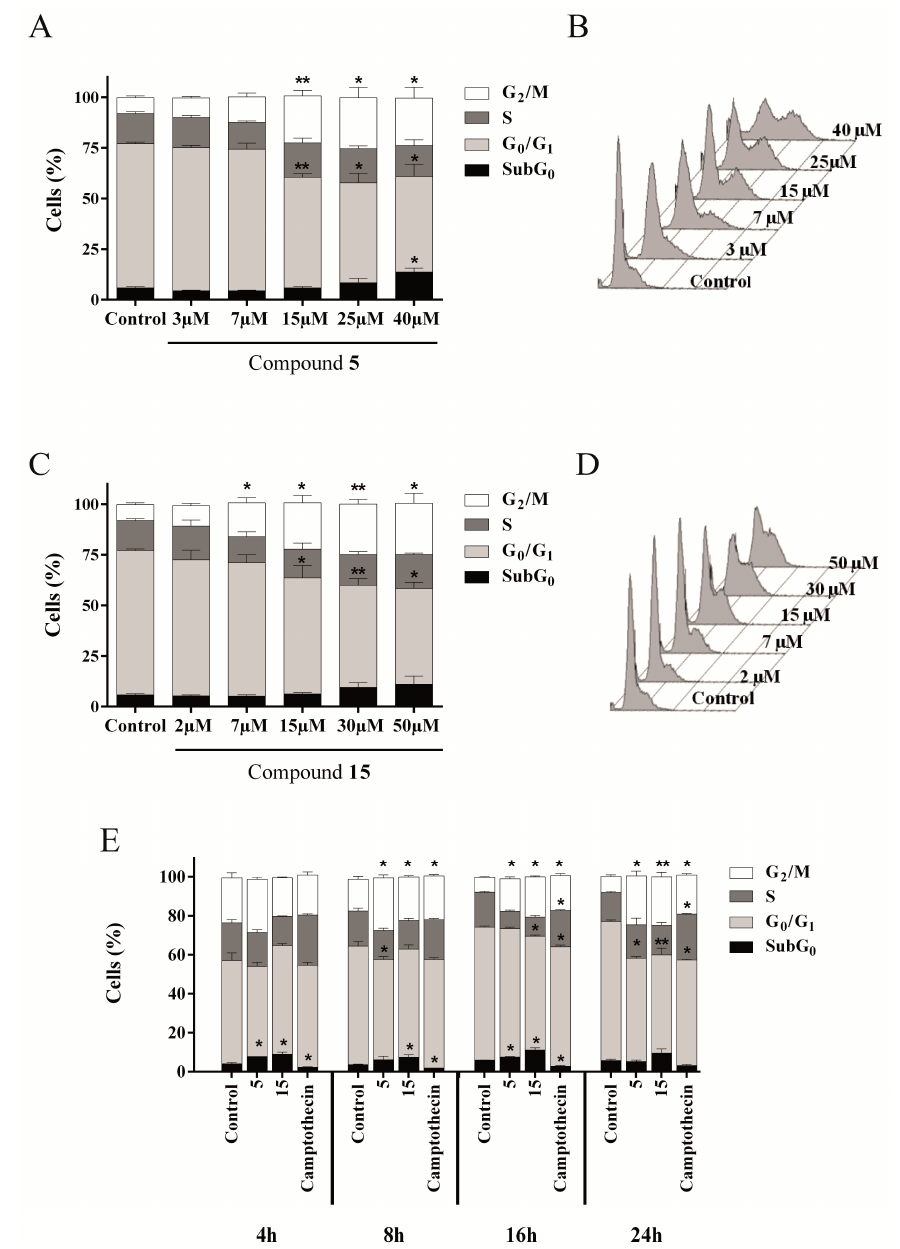
Figure 4. Compounds 5 and 15 induce cell cycle arrest in G 2 /M phase in MCF7. MCF7 cells were treated with different concentrations of compound 5 , 15 or vehicle (control) for 24 h or for different time periods. Cells were stained with propidium iodide with the Apo-Direct kit and analyzed by flow cytometry. ( A ) Quantification of cell cycle distribution after 24 h treatment with increasing concentrations of compound 5 ; ( B ) Representative experiment of A; ( C ) Quantification of cell cycle distribution after 24 h treatment with increasing concentrations of compound 15 ; ( D ) Representative experiment of C; ( E ) Cell cycle distribution after treatment with vehicle, 15 μ M of compound 5 or 30 μ M of compound 15 for different times. Results represent the mean ± SEM of at least three independent experiments performed in duplicate. * p < 0.05, ** p < 0.01.